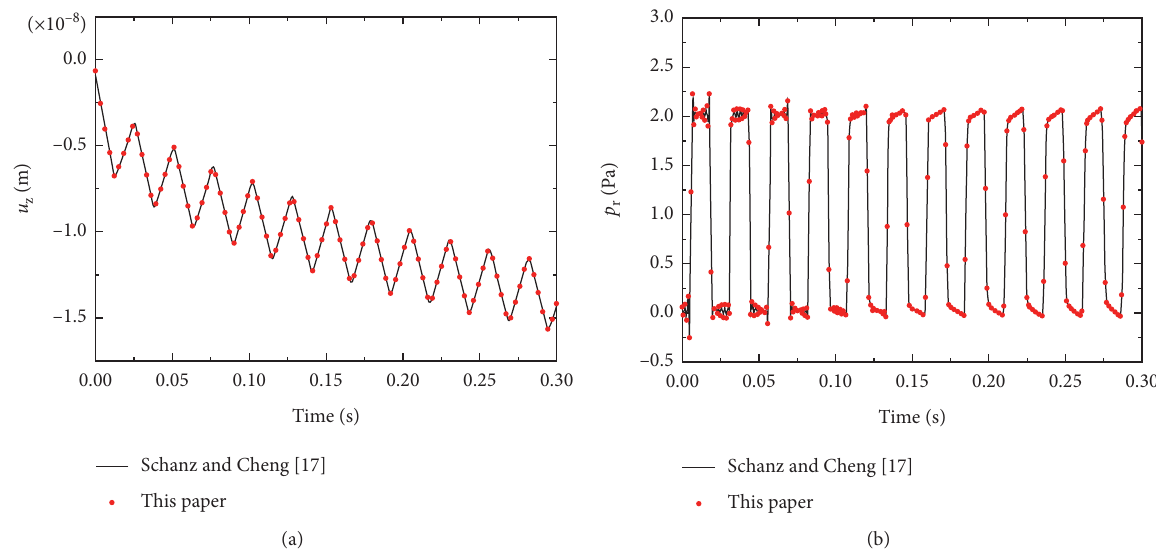
� L ) and the fluid pressure p � 0) calculated in this study z ( t , z f ( t , z